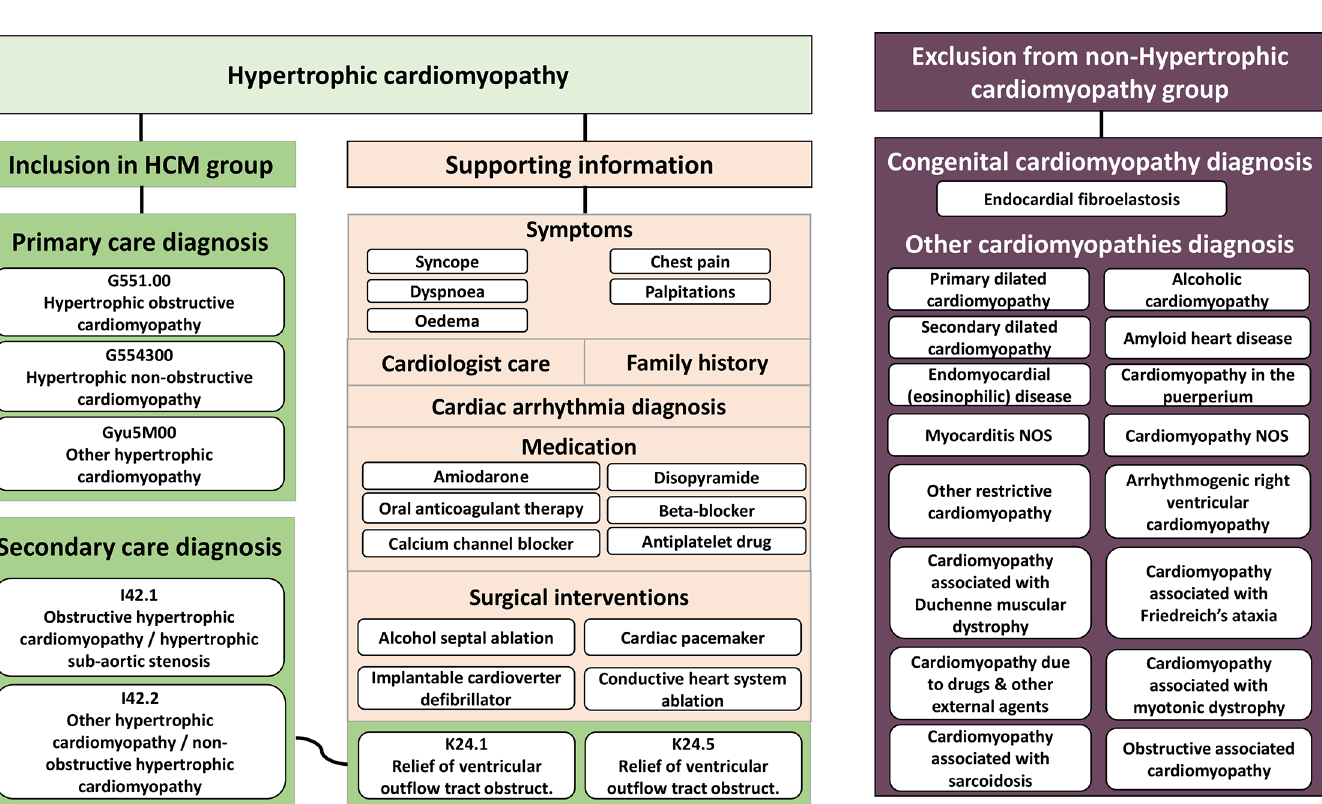
Fig 1. Defining cases of hypertrophic cardiomyopathy and non hypertrophic cardiomyopathy in national samples of structured electronic health records: phenotype algorithm using multiple ontologies (ICD-10, Read-2, OPCS-4, BNF). [Fig note: The phenotype algorithm uses multiple ontologies: the International Classification of Disease version 10 (ICD-10), the Read classification system, the Office of Population Censuses and Surveys Classification of Intervention and Procedures (OPCS) and the British National Formulary (BNF). Grey shaded areas indicate how the algorithm was constructed for the definition of hypertrophic cardiomyopathy (HCM) in primary analysis. Record of symptoms, cardiologist care, cardiac arrhythmia, medication and/or surgery within +/-6 months of a recorded HCM diagnosis was considered evidence of supporting information of HCM. HA, hospital admissions; PC, primary care.].